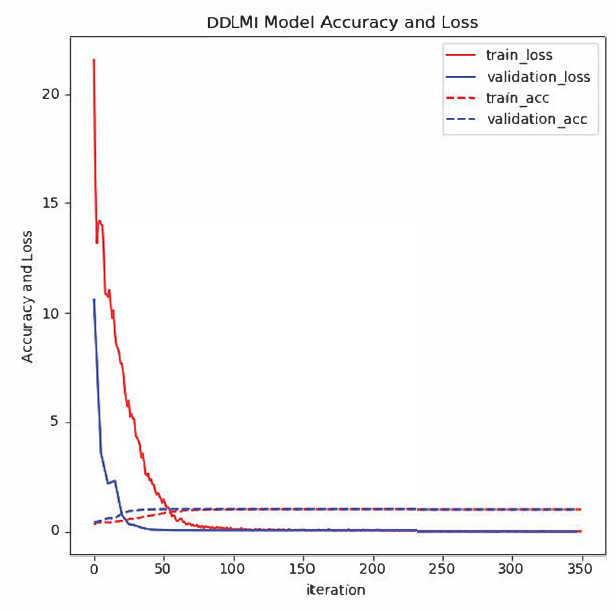
Figure 9. Average training and validation set accuracy performance over 50 iterations for DDLMI model.